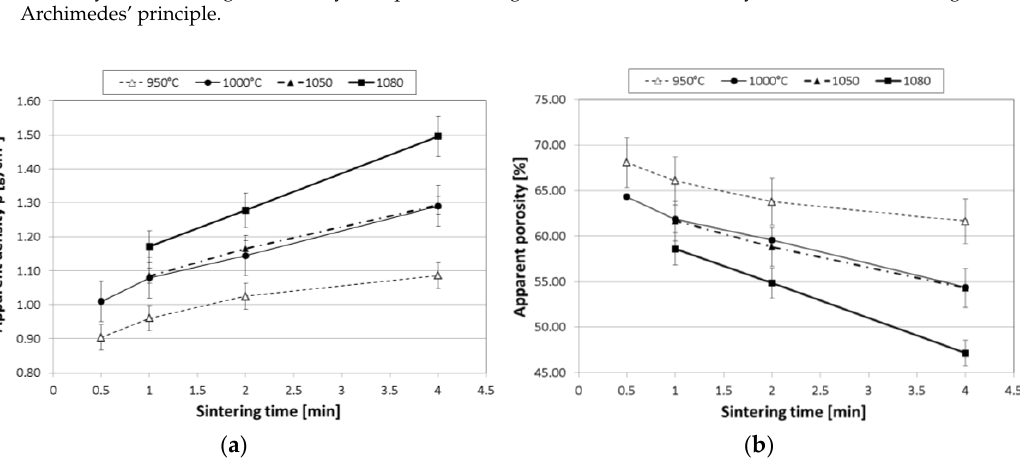
Figure 2. Dependence of ( a ) density determined according to Archimedes’ principle; and ( b ) apparent porosity on spark plasma sintering (SPS) conditions for Cu@CS materials, measured on cylindrical samples.